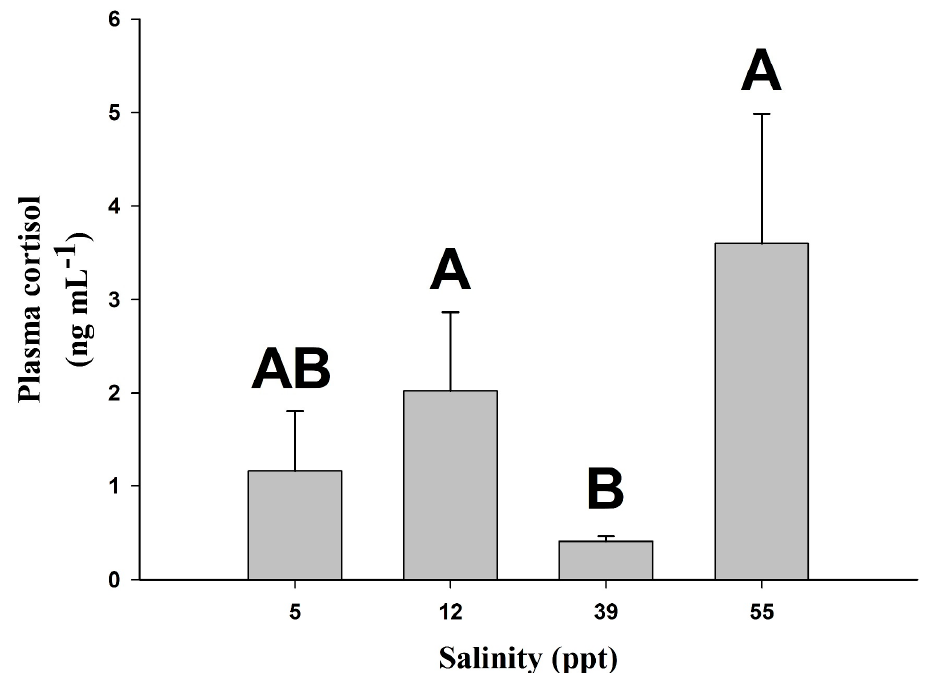
Figure 3. Plasma cortisol concentration in A. regius juveniles acclimated to different environmental salinities (5, 12, 39, and 55 ppt) for 21 days. Results are expressed as the mean ± SEM ( n = 7). Different letters indicate significantly different groups ( p < 0.05, one-way ANOVA followed by Tukey’s post-hoc test).